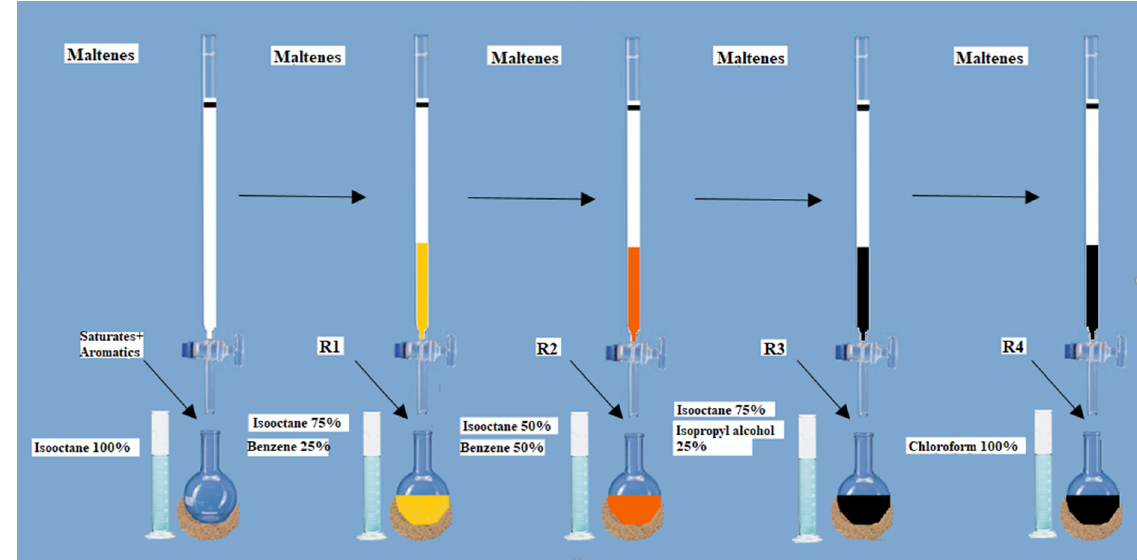
Figure 8. Scheme of resins fractionation.